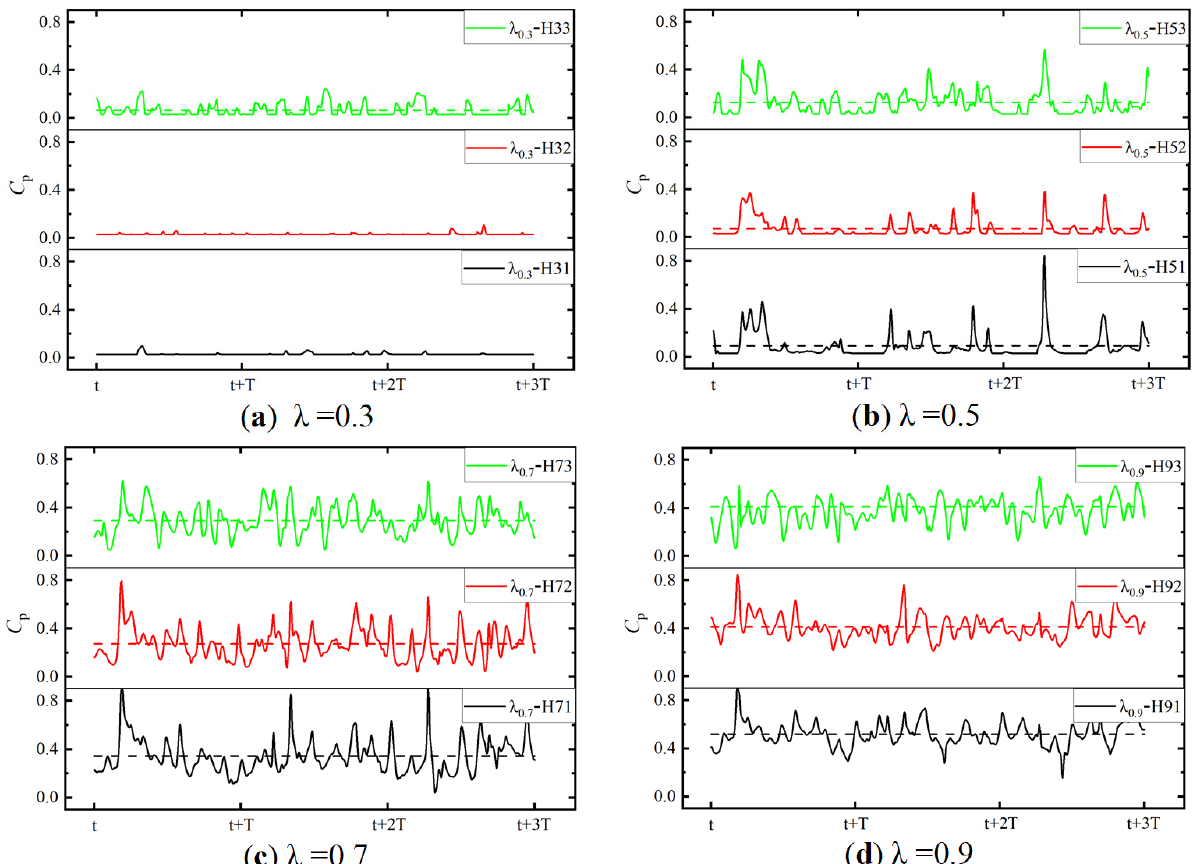
Figure 20. The pressure coefficient curves at different monitoring points ( Q = 0.8 Q BEP , σ = 0.35).